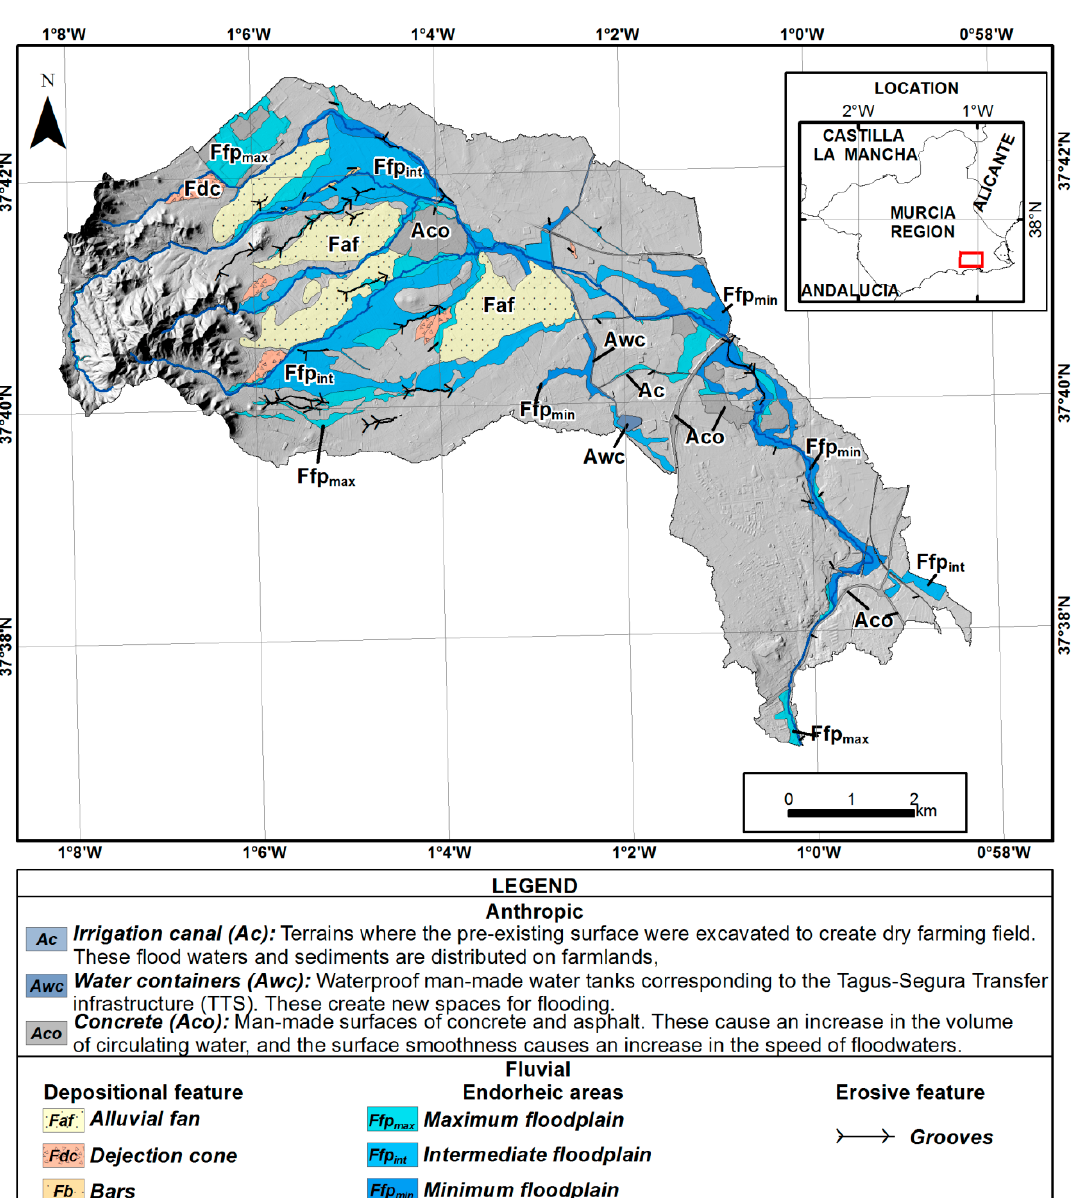
Figure 10. Fluvial geomorphology in the Rebollos watershed. Anthropic and fluvial agents were included in the analysis.